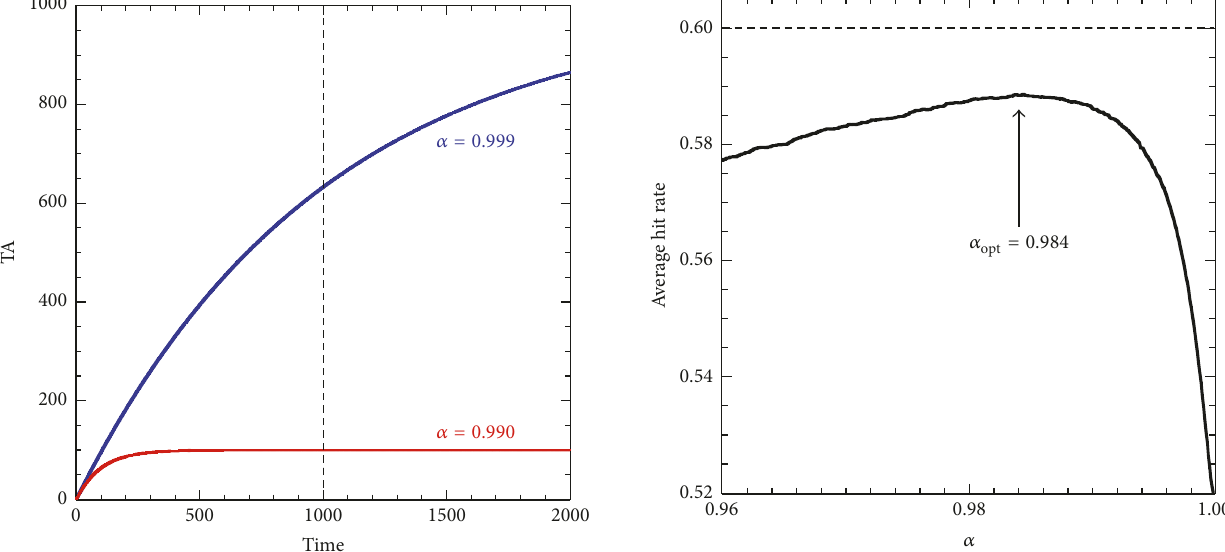
Figure 6: Time evolution of the threshold adjuster (TA) value described in (4) for 𝛼 = 0.990 (red line) and 0.999 (blue line) when 𝑋(𝑖) = 1 is assumed for all 𝑖 .